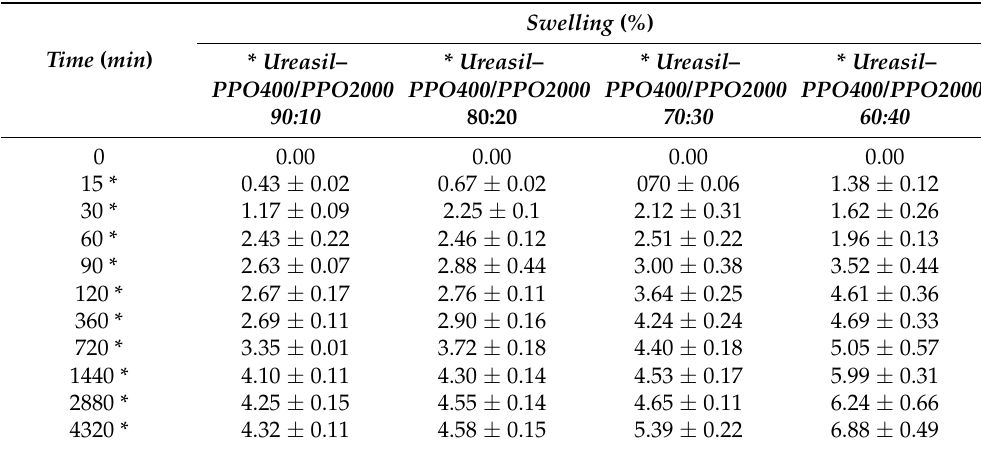
Table 1. Percentage of swelling of membranes from the mixtures of ureasil–polyether precursors in the proportions of 90:10; 80:20; 70:30 and 60:40, immersed in phosphate buffer at pH 7.2.